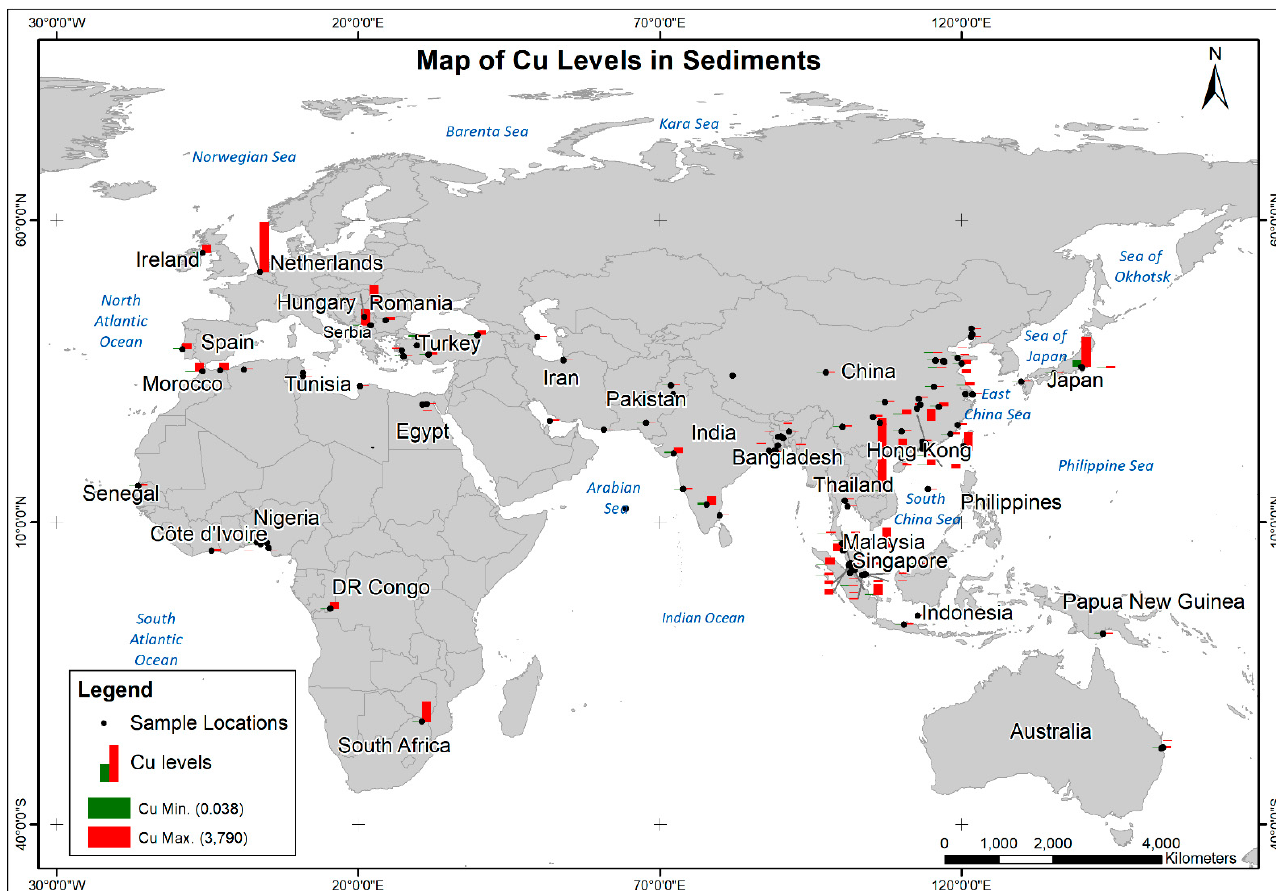
Figure 2. A world map covering the continents of Africa and Europe and the Asia–Pacific areas for the Cu levels in the sediments cited in the 125 publications. Source: https://www.efrainmaps.es/english-version/free-downloads/world/ (assessed on 1 June 2022).